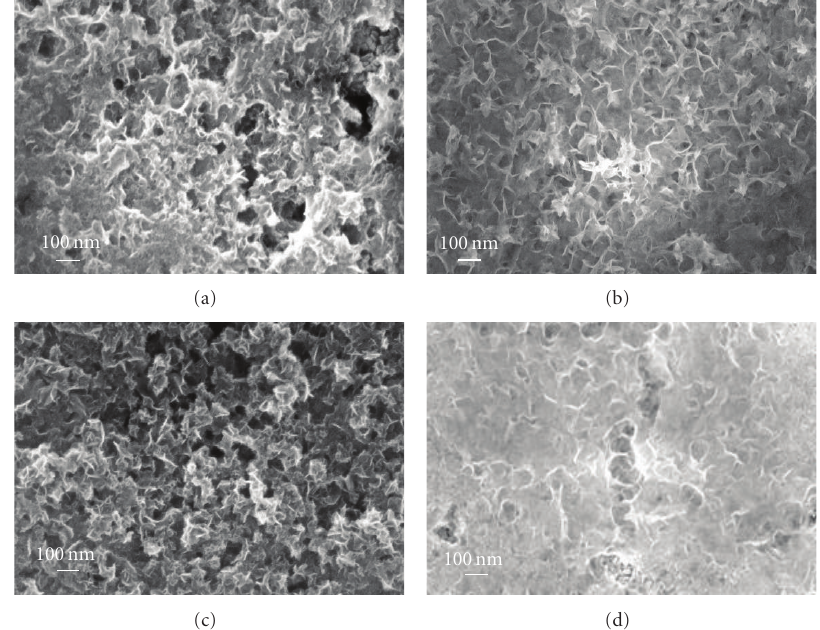
Figure 4: FESEM micrographs of MnO 2 thin films on Ni-coated PET films at deposition duration of (a) 1 min, before, (b) 1min, after, and (c) 60 min, before, (d) 60 min, after calcination at 200 ◦ C in air for 1 hour.